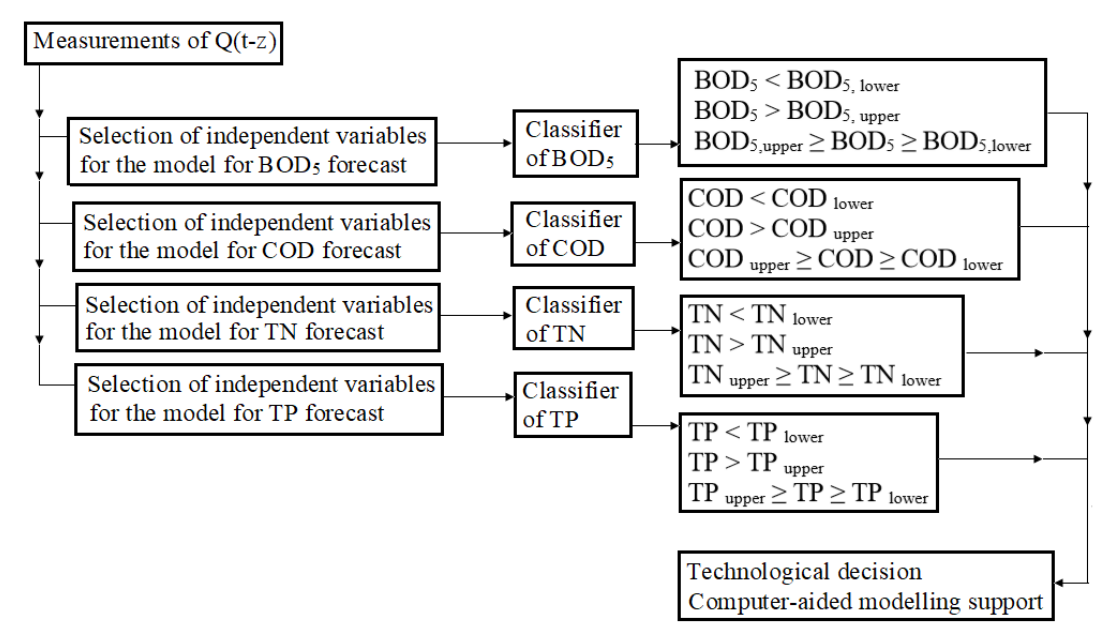
Figure 2. Diagram of an expert system for identifying wastewater quality: BOD 5 , COD, TN, TP — “typical” values of wastewater quality indicators; BOD 5,lower , COD lower , TN lower , TP lower — reduced values of wastewater quality indicators, BOD 5,upper , COD upper , TN upper , TP upper — elevated values of wastewater quality indicators, Q ( t ) — inflow to the wastewater treatment plant at time t , z — delay values.